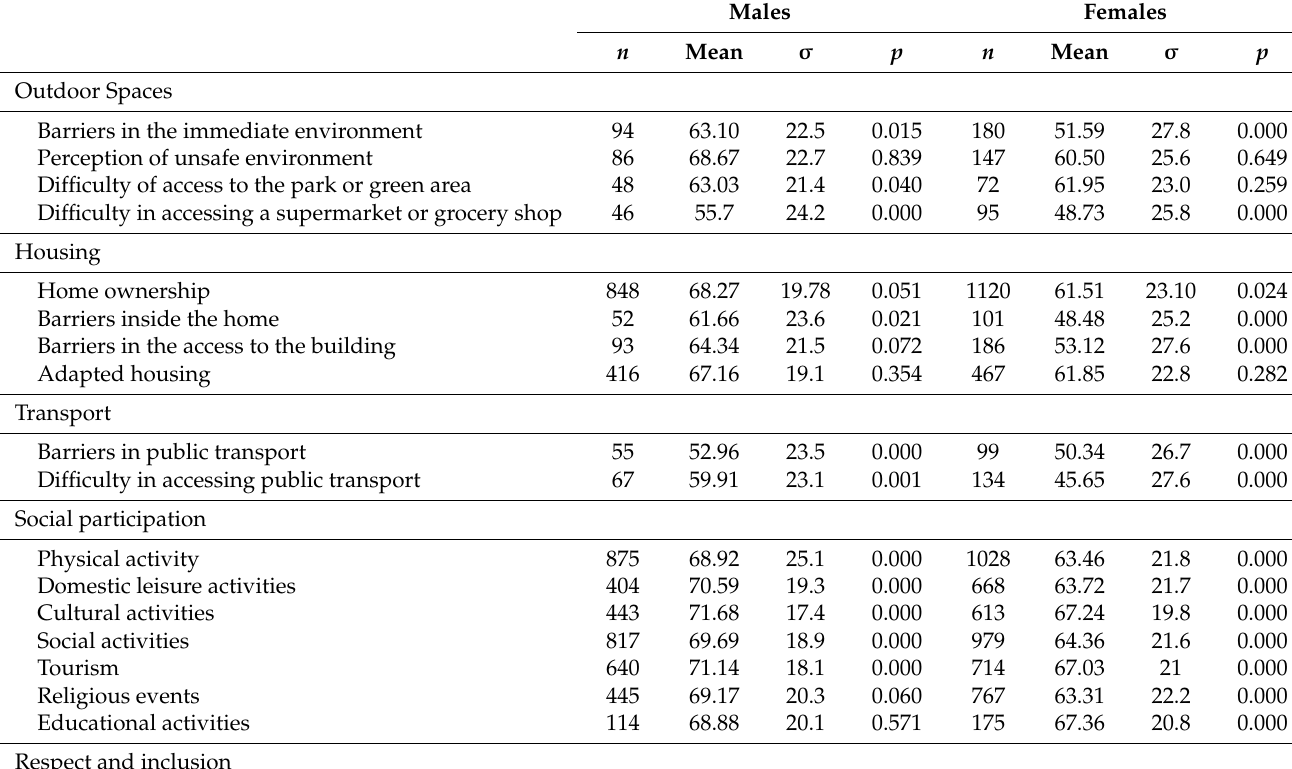
Table 4. Subjective well-being according to components of age-friendliness by